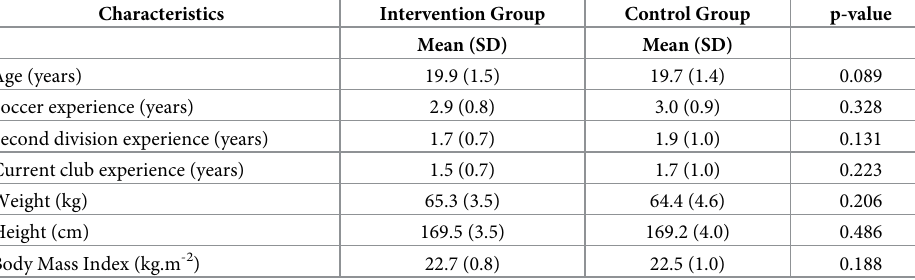
Table 1. Demographic characteristics of players in the intervention and control